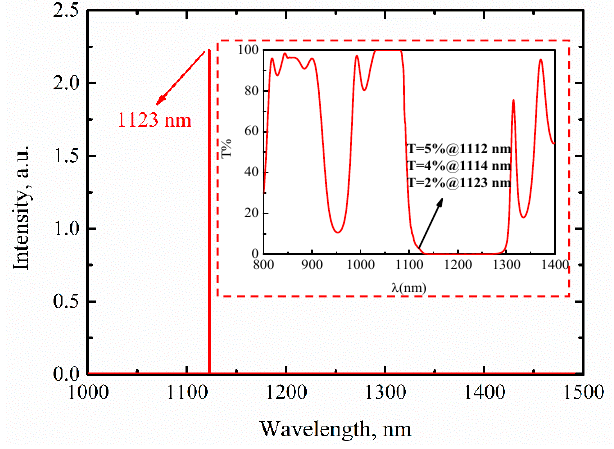
Figure 3. The output spectrum of the L-type TM cavity laser. The inset shows the transmission curve as a function of wavelength for the output coupler (OC).